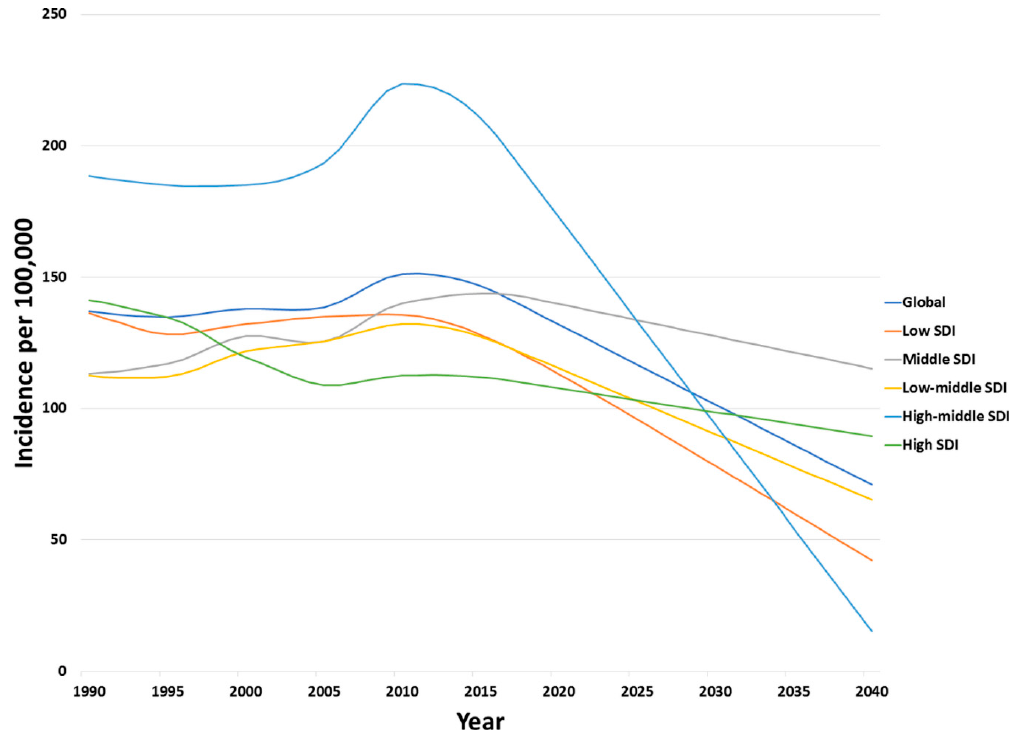
Figure 3. Forecasted trends for age-standardized incidence rates for pedestrian road traffic injuries per 100,000 population across sociodemographic indices 1990 – 2017.